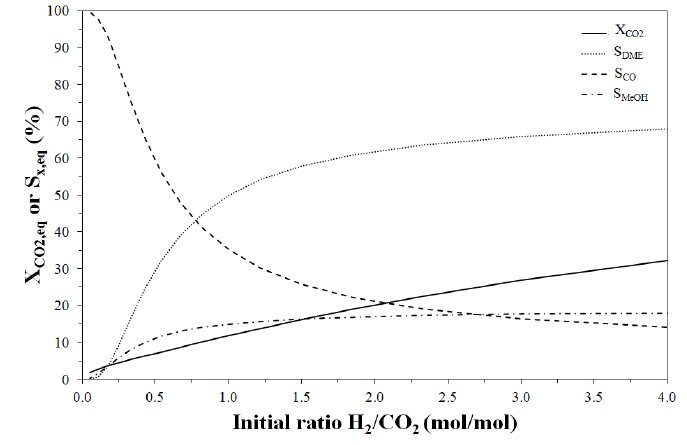
Figure 6. Effect of initial H 2 /CO 2 molar ratio on CO 2 equilibrium conversion and DME, CO and methanol equilibrium selectivity. Reaction temperature and pressure: 240 °C and 30 bar, respectively.